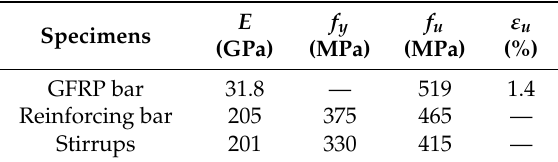
Table 4. Material properties of bars and